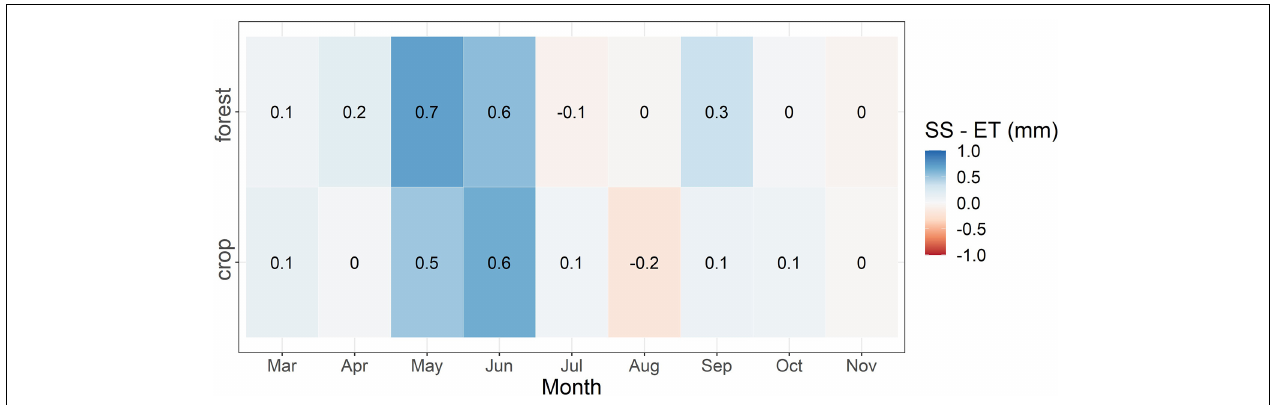
FIGURE 5 | Sen’s slope (SS) values of evapotranspiration (ET mm) for forest and croplands in each month.